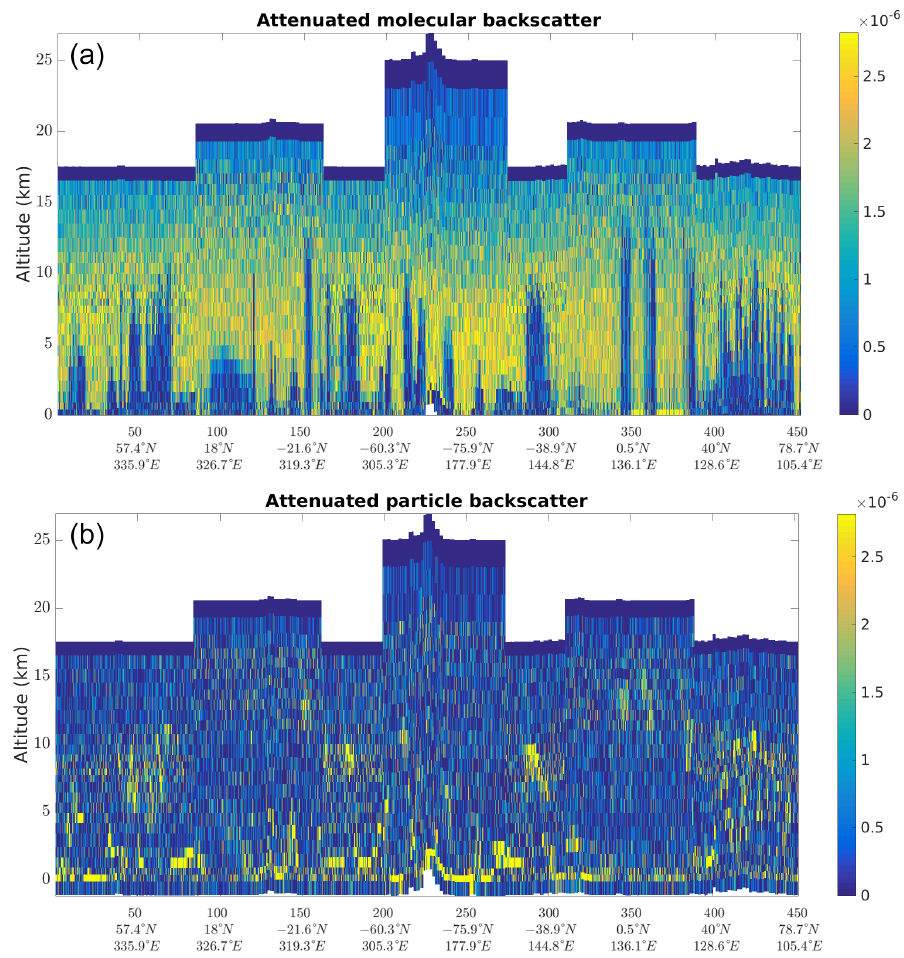
Figure 6. Molecular attenuated backscatter (a) and particulate attenuated backscatter (b) are shown here on orbit file no. 10568 at measure- ment scale, with units sr − 1 m − 1